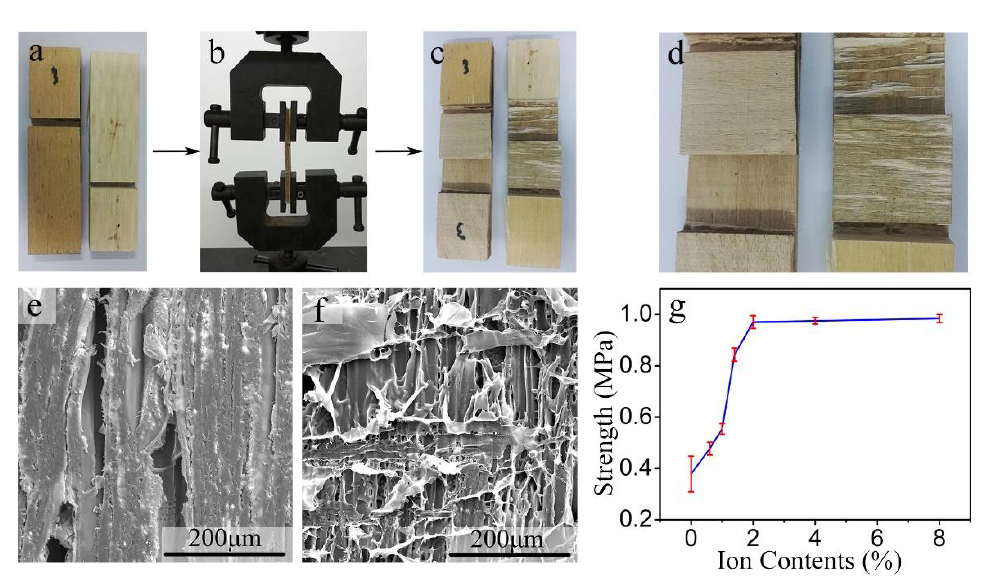
Figure 5. ( a ) Tailored bonded wood specimen; ( b ) set on the universal mechanical testing machine; ( c ) break sample of a; ( d ) the fracture surface of PVA-0.0% (left) and PVA-2.0% (right) specimen; SEM images of ( e ) PVA-0.0% and ( f ) PVA-2.0% specimen; ( g ) bonding strength of the bonded wood samples with different addition amounts of ferric ions.